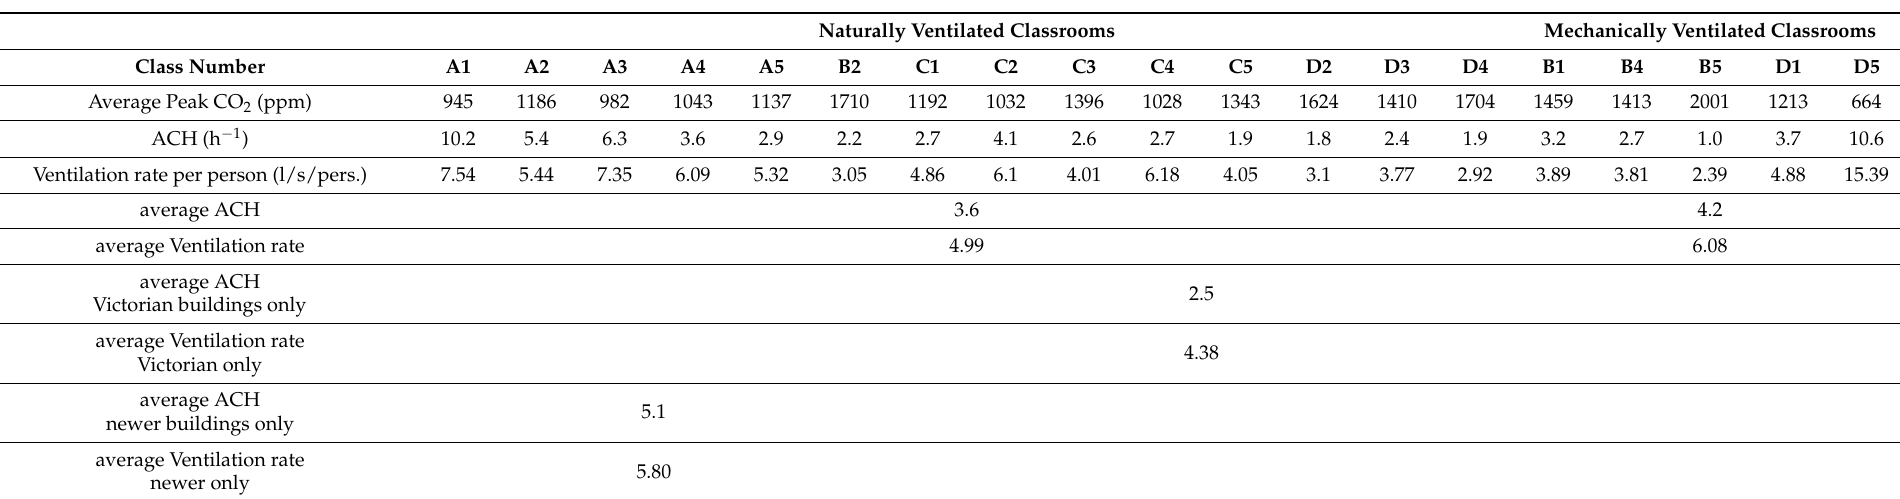
Table 3. Peak CO 2 concentration and the estimated ventilation rates in classrooms with different ventilation